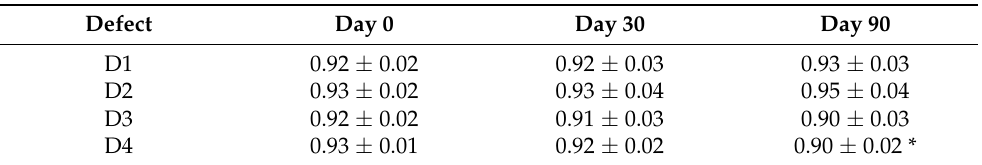
Table 2. Relative bone density (mean ± standard deviation) of calvarial defects of rats on day 0 ( n = 24), 30 ( n = 24) and 90 ( n = 12).